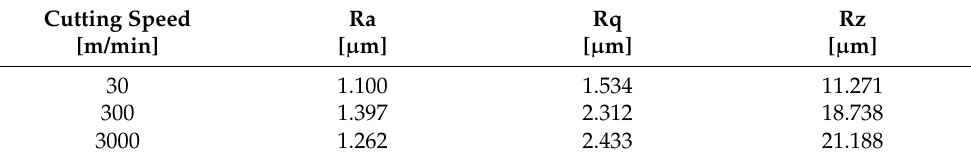
Table 8. Recorded values of surface roughness after machining of alumina.